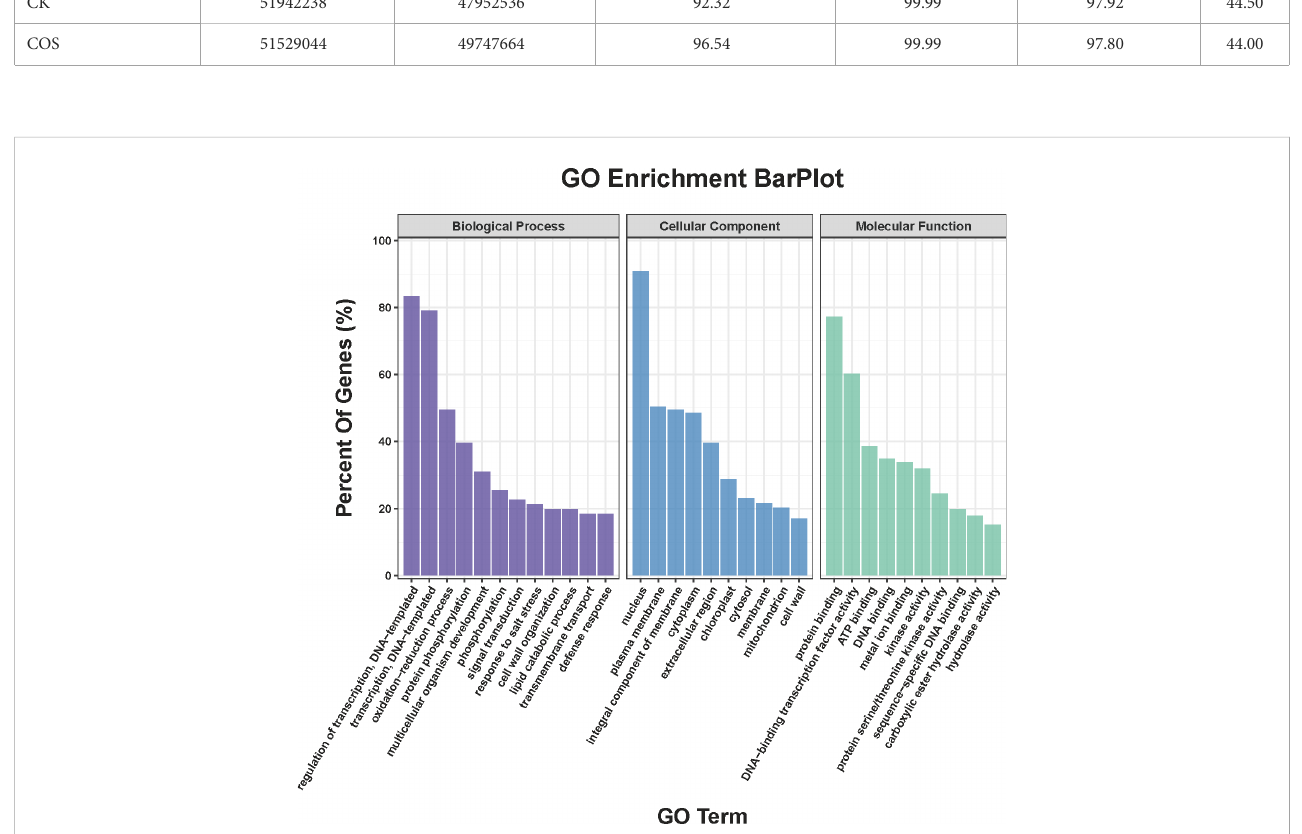
FIGURE 3 GO classi fi cation of